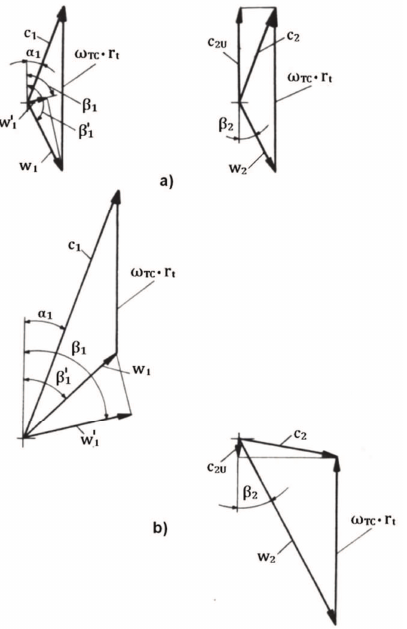
Fig. 2. Velocity diagrams at turbine rotor blades, inlet and exit at scavenging ( а ) and exhaust (b) – а 8 С 22 diesel for ω d = 52 rad/s, α 1 – angle of flow exit from nozzle unit; β 1 – direction of shock-free inlet to the rotor blades; β′ 1 – direction of relative velocity of flow at inlet of the rotor blades; β 2 – angle of flow exit from the rotor blades in relative